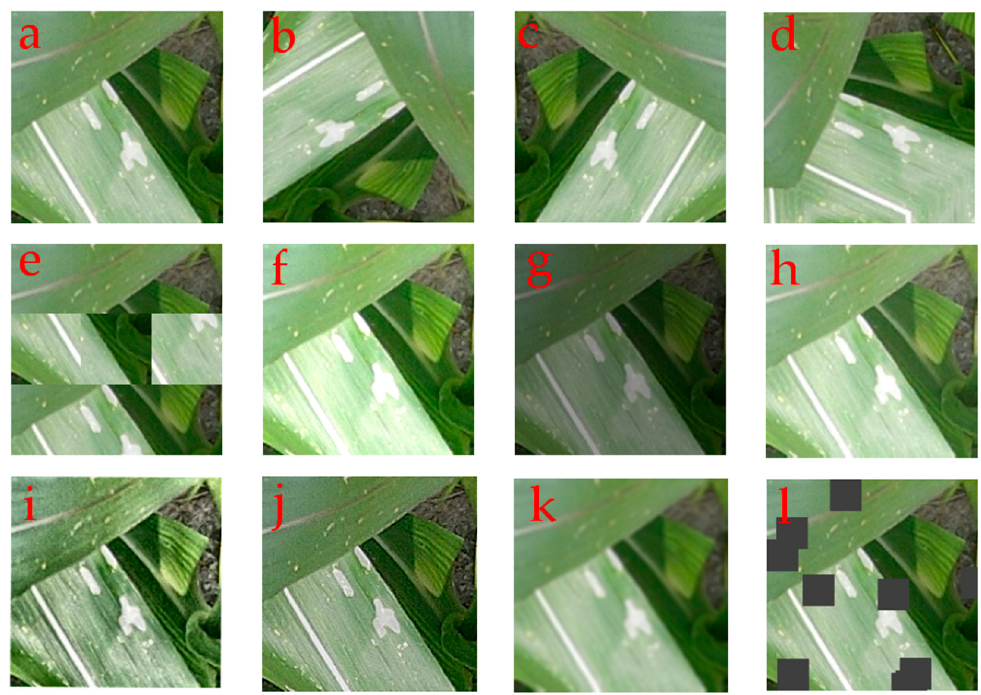
Figure 5. Augmentation: ( a ) The original image; ( b , c ) Horizontal flips and rotations of 90°, respectively; ( d ) Shift scale rotate; ( e ) Random grid transformation; ( f , g ) Contrast transformation; ( h ) Random Contrast transformation; ( i ) IAASharpen; ( j ) IAAEmboss; ( k ) CLAHE; ( l ) Shift cutout.